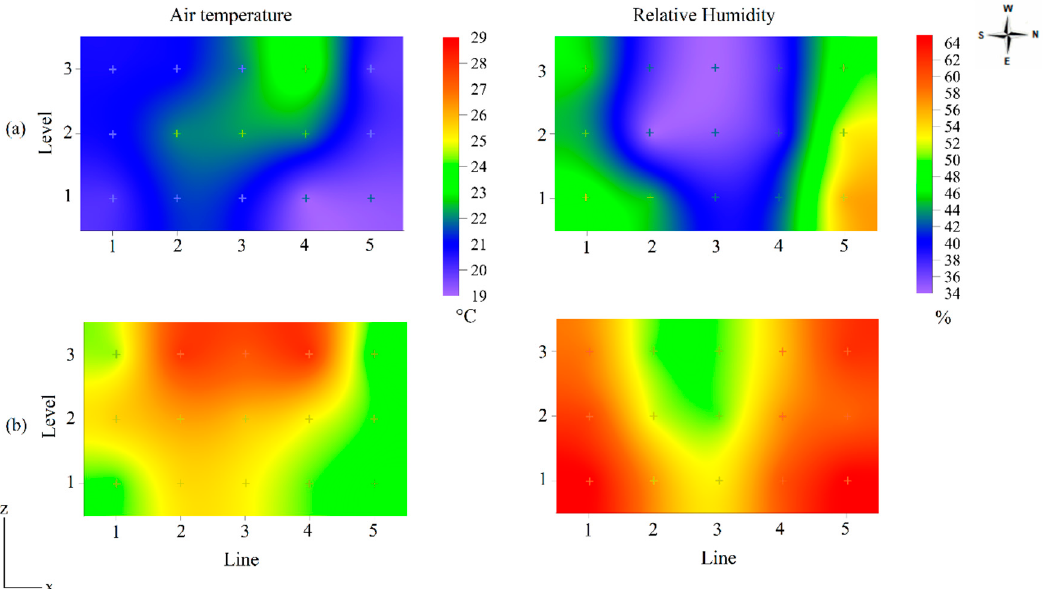
Figure 3. Spatial distribution of air temperature and relative humidity inside the aviary with 43-week-old laying hens (43W), in winter ( a ) and summer ( b ).